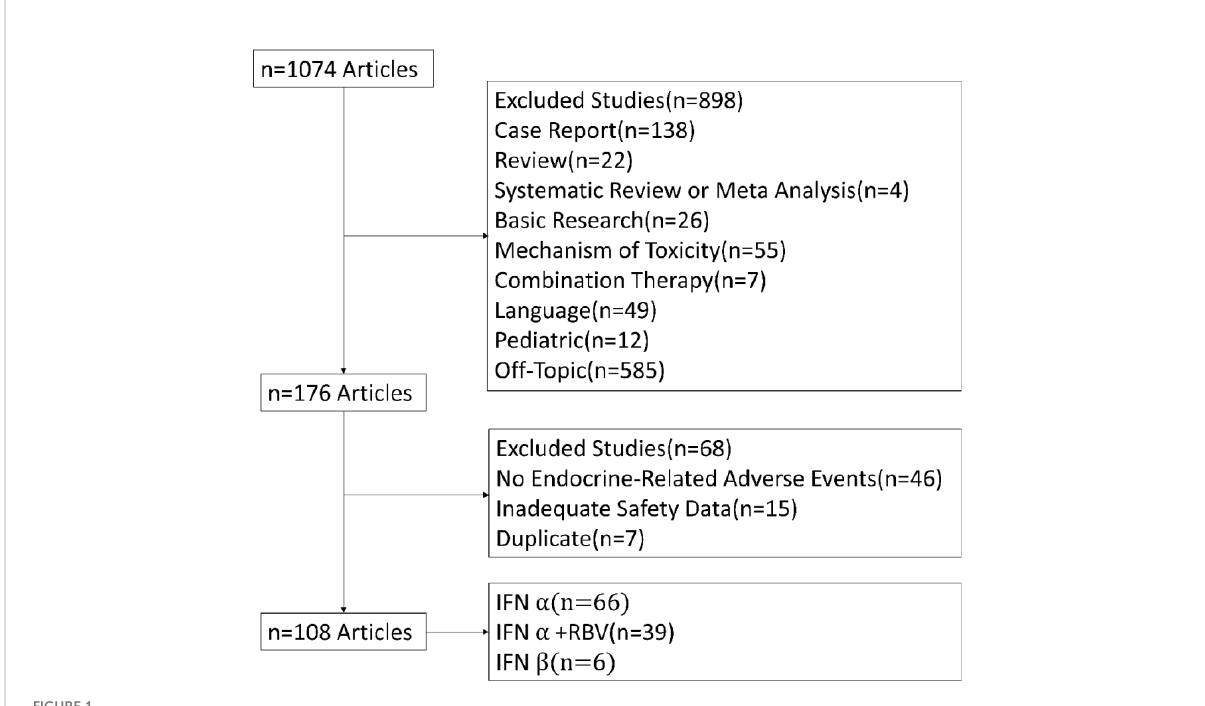
FIGURE 1 Flow chart of study